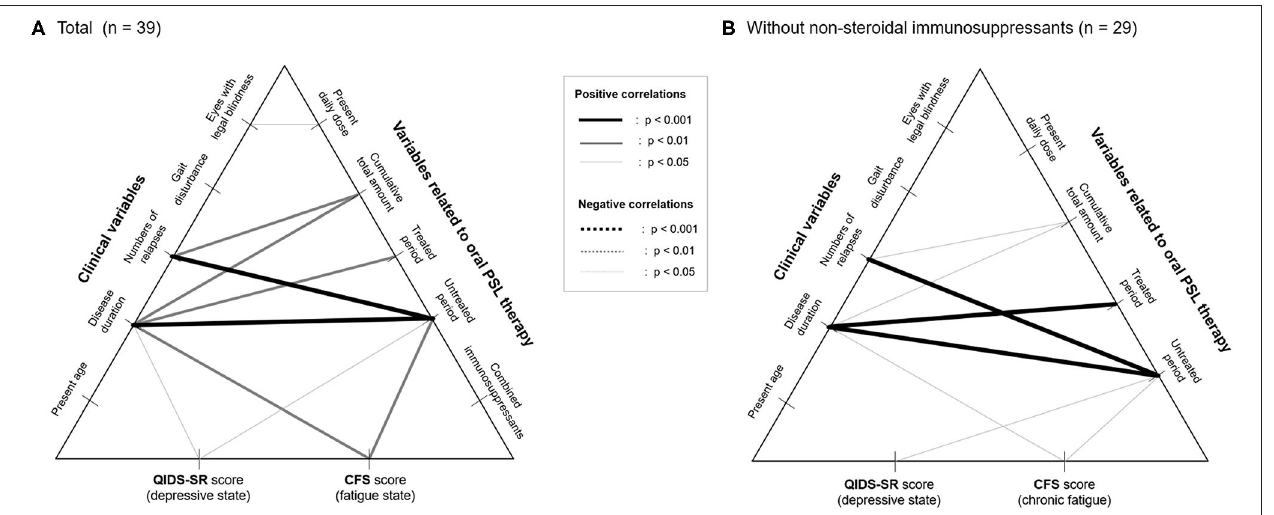
Depressive state (QIDS-SR) Chronic fatigue (CFS) rho